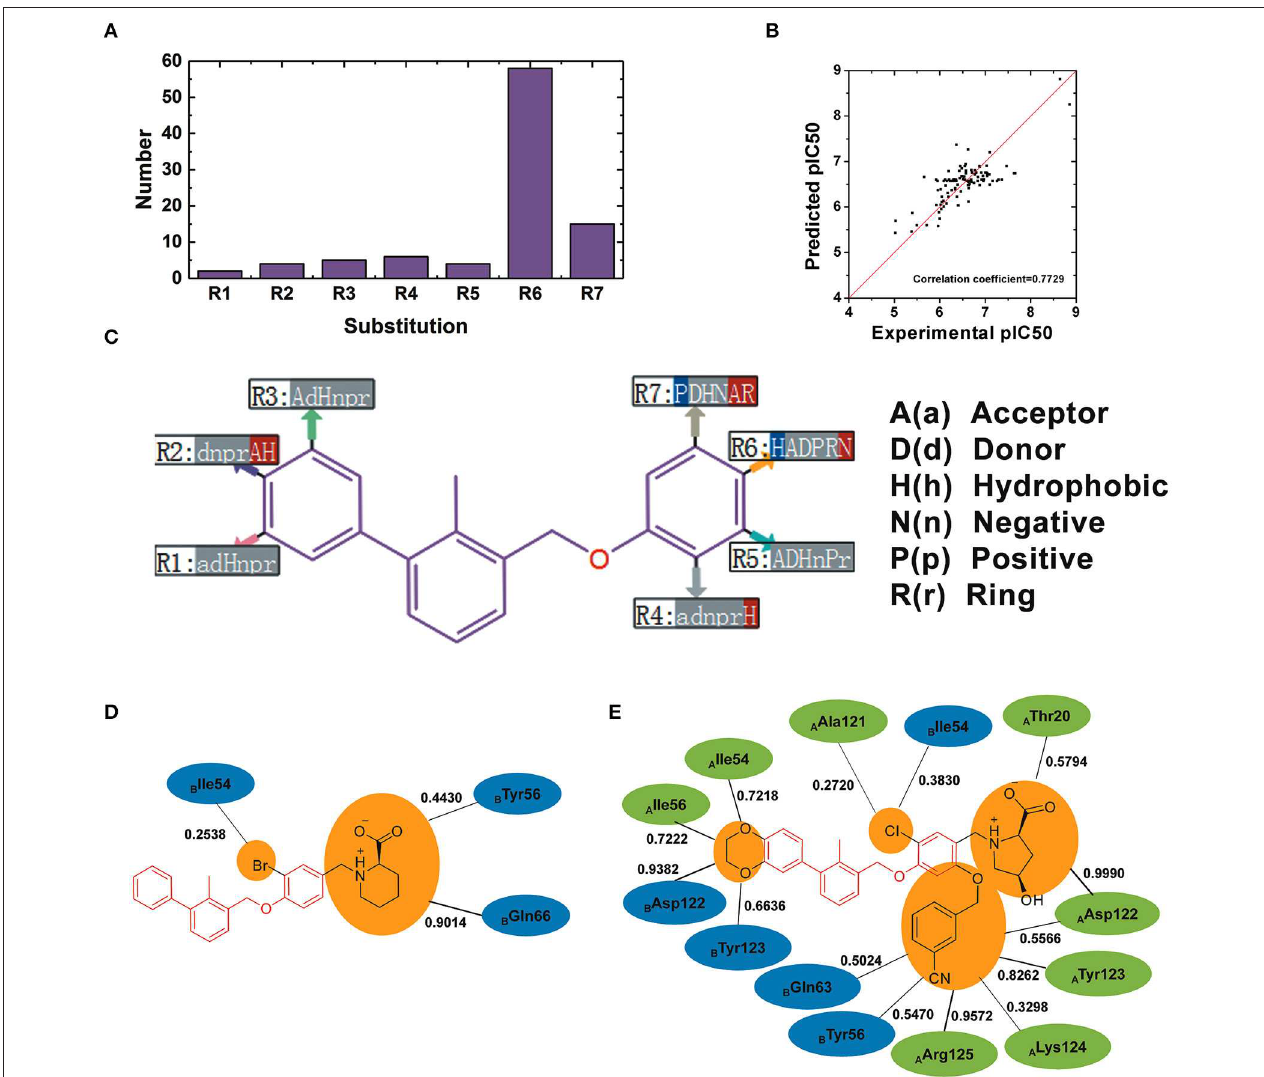
FIGURE 9 | The R-group based QSAR for BMS small-molecule inhibitors. (A) The number of substituent groups at seven attachment points of BMS small molecule inhibitors. (B) The correlation validation between the predicted pIC50 and experimental pIC50. (C) R-group QSAR model for the BMS small molecule inhibitors. The case-insensitive alphabets A(a), D(d), H(h), N(n), P(p), and R(r), respectively represent the hydrogen bond acceptor, the hydrogen bond donor, the hydrophobic, the negative ionic, the positive ionic, aromatic ring. The significantly increase effect is colored in red while the significantly decrease effect is colored in blue. (D,E)